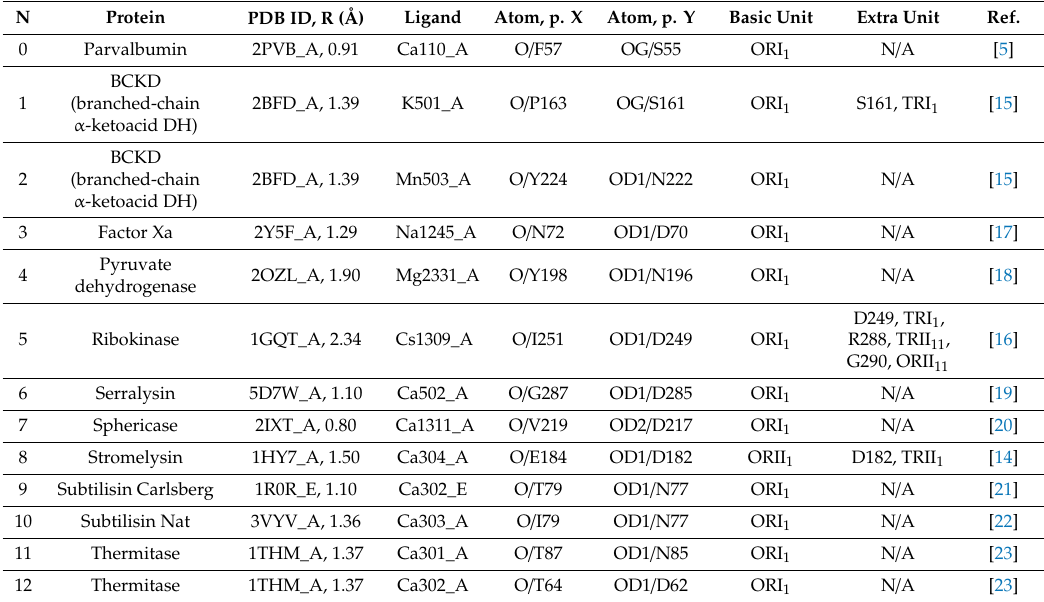
Table 1. Existence of the Clamp n,(n − 2) unit in the metal cation-binding sites of proteins with “niche” motifs in these